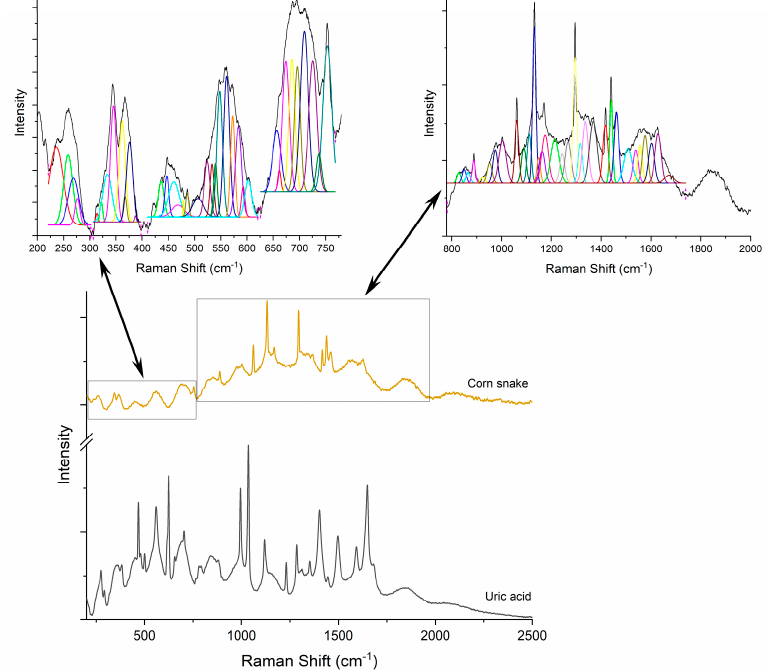
Figure 5. Raman spectra of pure uric acid and, respectively, corn snake sample.